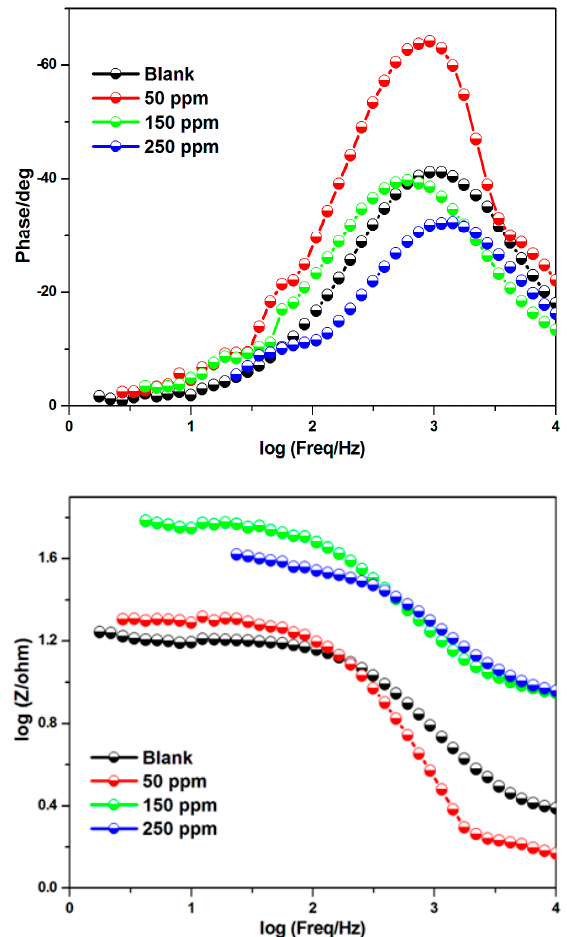
Figure 5. Bode and phase plot diagrams for the MS specimen in 1M HCl in various concentrations of T. aralioides